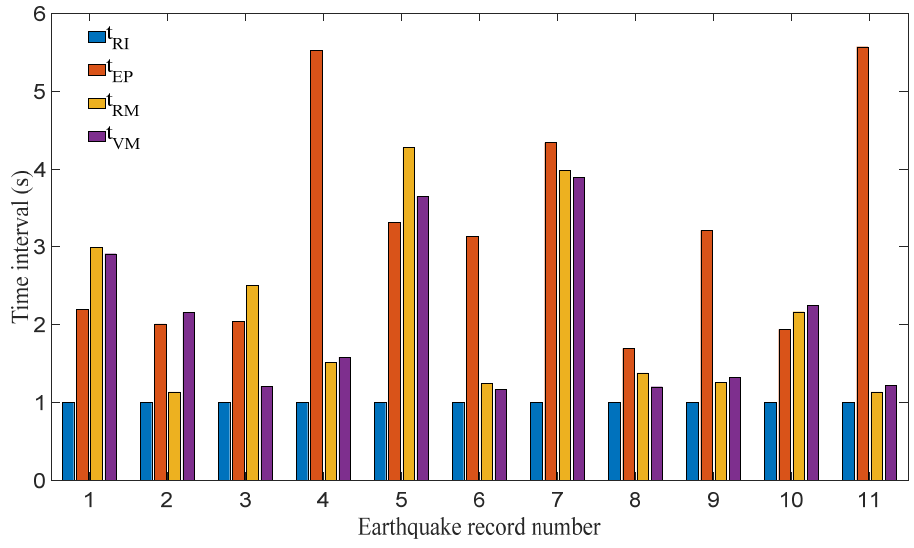
Figure 9. Unified key time points in the case of far-field earthquakes.